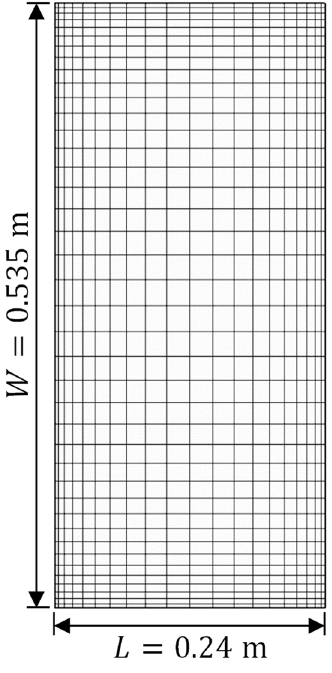
Figure 3. Computational domain mesh.